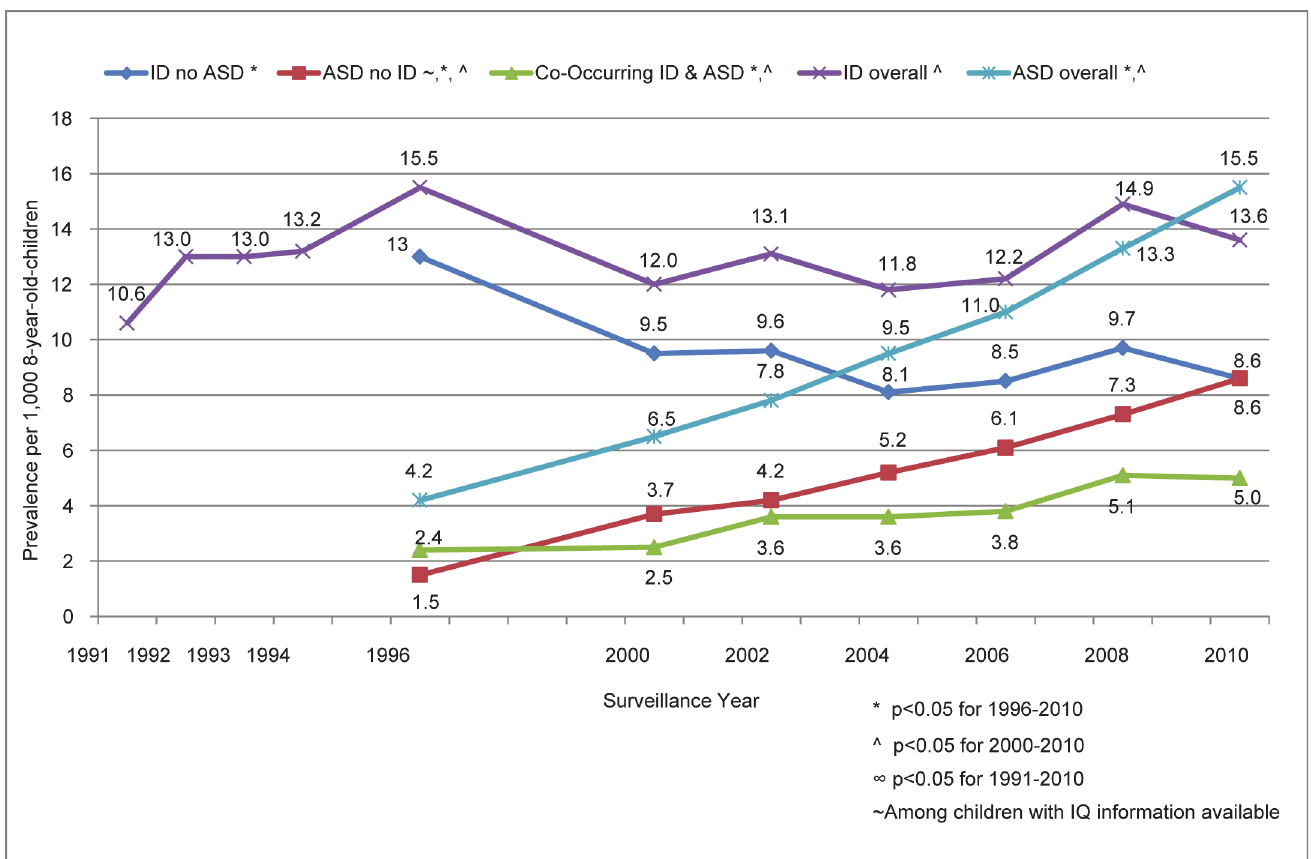
Fig 2. Prevalence of Co-occurring Intellectual Ability and Autism Spectrum Disorder, 1991 –